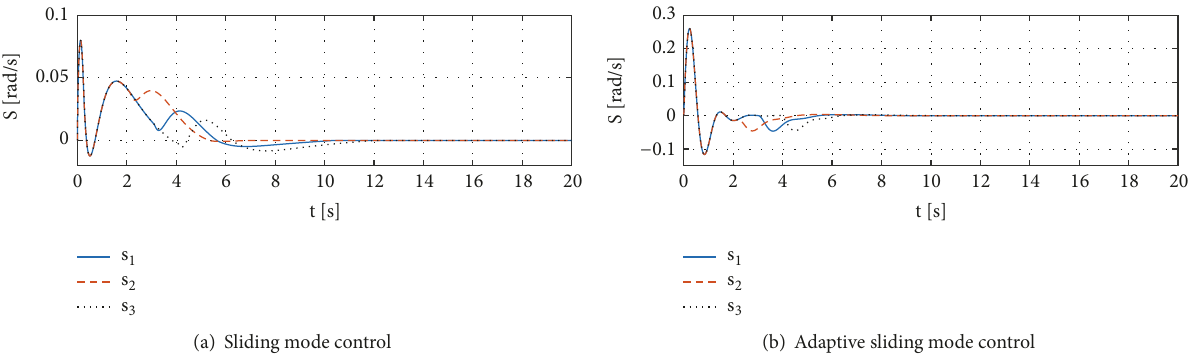
Figure 7: The sliding mode surface of each controller.